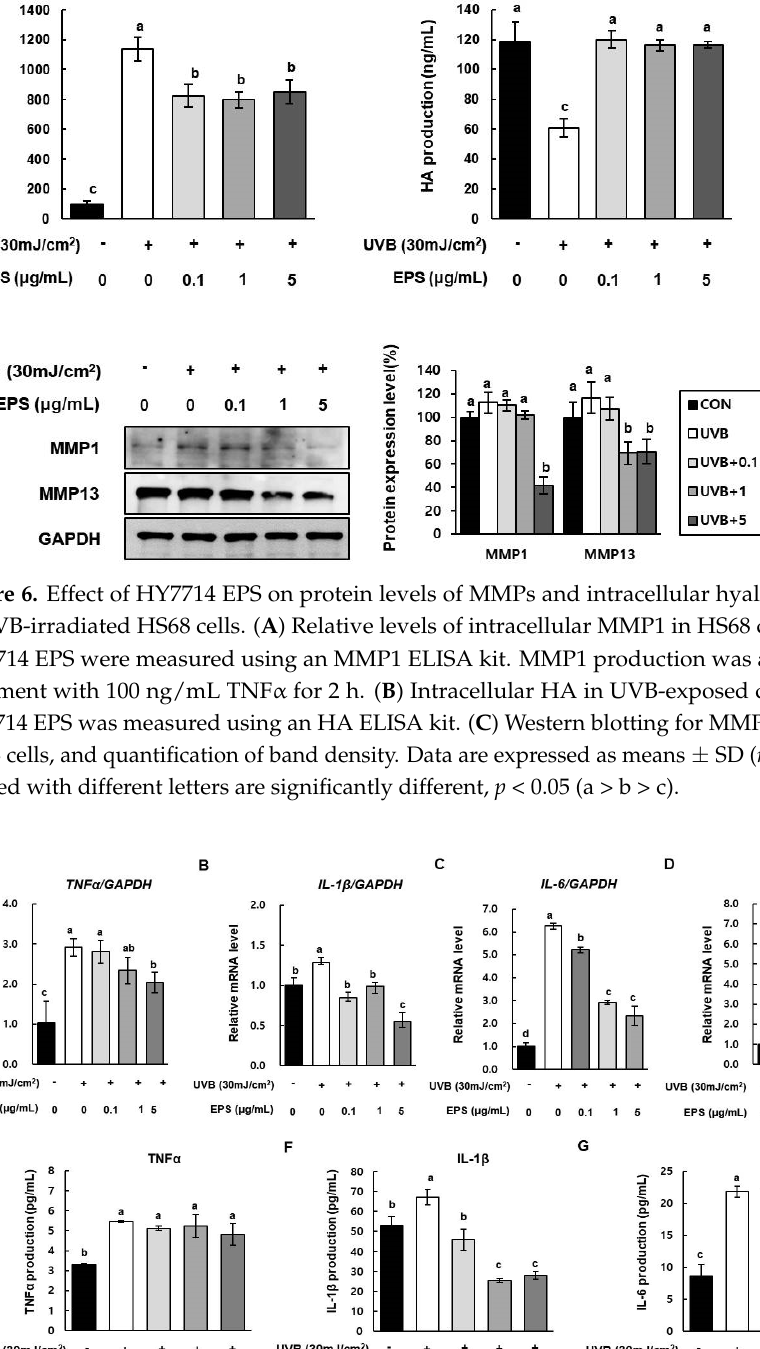
Figure 6. Effect of HY7714 EPS on protein levels of MMPs and intracellular hyaluronic acid (HA) in UVB-irradiated HS68 cells. ( A ) Relative levels of intracellular MMP1 in HS68 cells treated with HY7714 EPS were measured using an MMP1 ELISA kit. MMP1 production was amplified by pre-treatment with 100 ng/mL TNF α for 2 h. ( B ) Intracellular HA in UVB-exposed cells treated with HY7714 EPS was measured using an HA ELISA kit. ( C ) Western blotting for MMP1 and MMP13 in HS68 cells, and quantification of band density. Data are expressed as means ± SD ( n = 3), and values labeled with different letters are significantly different, p < 0.05 (a > b > c).